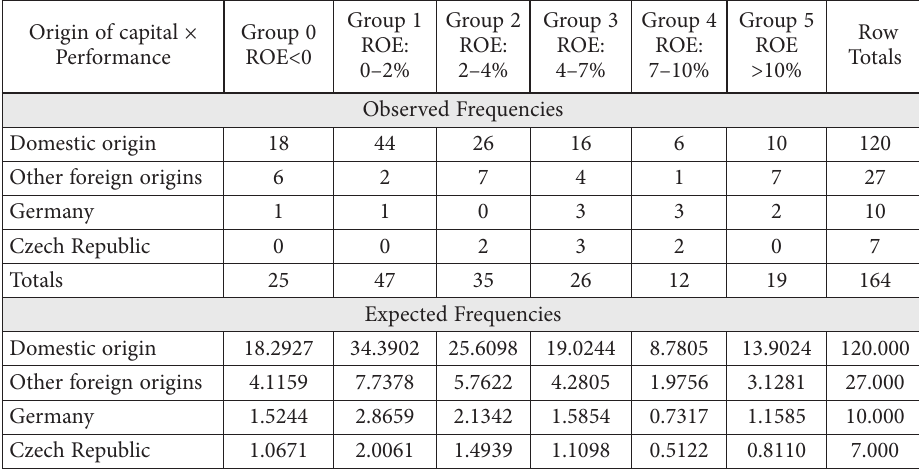
Table 6. Contingency: origin of capital x performance – frequencies (source: